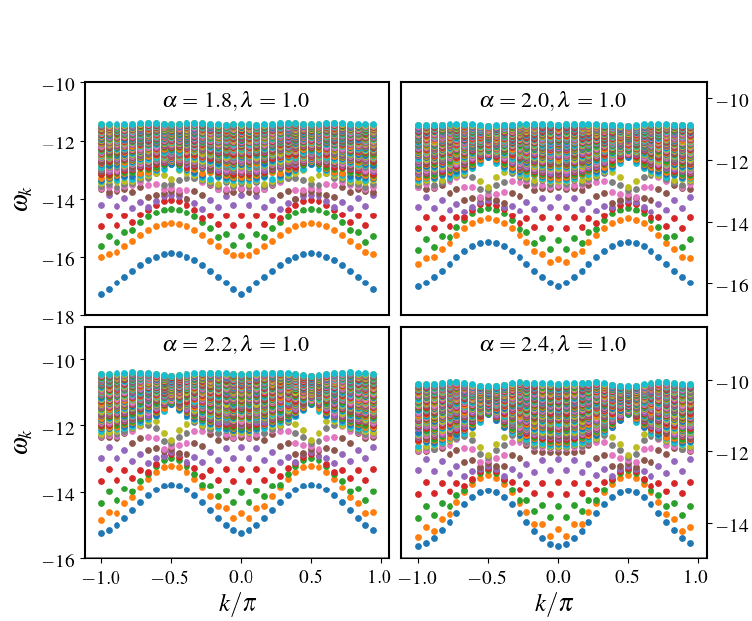
Figure 6: Spectra for λ = 1 and different values of α obtained by using Villain’s approach for L = 36, including the sector with three spinons and one